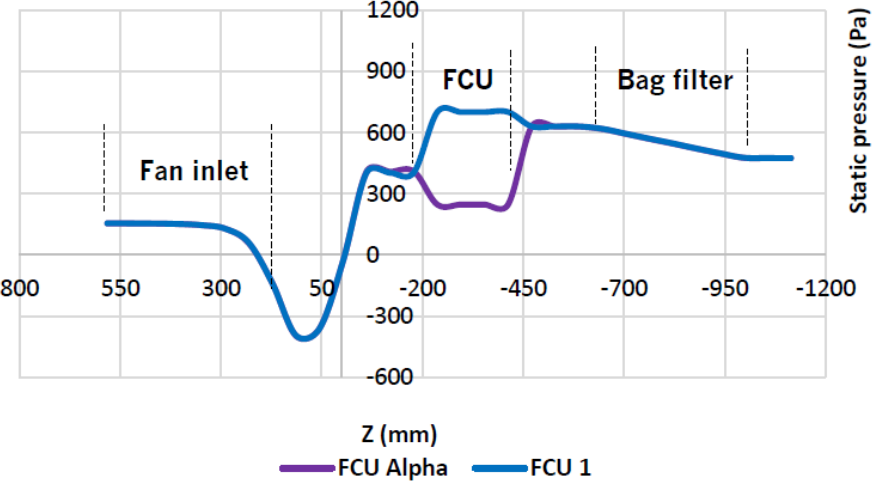
Figure 12. Static pressure curves obtained with FCU 1 and FCU Alpha, under real conditions. Static pressure curves obtained with FCU 1 and FCU Alpha over the whole domain are presented. An improvement in static pressure rise of 6.1% with FCU Alpha relative to FCU 1 is obtained. The reason why this value is relatively low may be due to the small distance between the fan exit and the bag filter entry. The objectives with FCU Alpha and its downstream geometric features were to improve the stability of the air flow at the bag filter inlet and decrease the Reynolds shear stress at the boundaries and downstream of the FCU. By transforming a bigger part of the energy, when passing around the FCU Al- pha, in pressure energy, the objective was to achieve a higher value of static pressure rise relative to FCU 1. Despite the improvement in the static pressure rise with FCU Alpha, it is was not expected a lower outlet static pressure. Being static pressure improvement relatively low, this difference may be due to mesh problems. 5. Conclusions The present work focuses on the analysis of the fluid flow inside an AHU. From this perspective, a numerical model, using the ANSYS Fluent software, was developed to in- vestigate and understand the fluid flow inside this type of machine and to study alterna- tive constructive solutions in order to optimize the operation of the AHU. In this research work, the most important findings are summarized as follows: Results of industry-academic collaboration to apply scientific research to understand and improve industrial products can be used to deliver more efficient products. In this case, a new design philosophy was explored with promising results that need more ex- tensive development to optimize the concept. The results obtained with the FBC model, when compared to the experimental meas- urements, are quite different. The considered fan modeling approach has revealed a de- cent agreement with the experimental results in terms of air volume flow rate calculated, despite the simplifications and assumptions are taken. Although, for the other parameters, as fan static pressure rise and bag filter pressure drop, relatively high errors were ob- tained. Several are the possible causes for these errors, as the geometric simplifications adopted, errors in the experimental measurements, and simplifications in terms of CFD